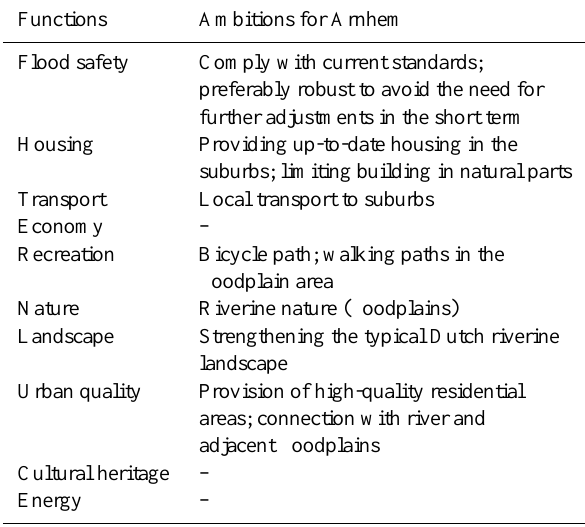
Table 5 lists envisaged functions for the Arnhem location.